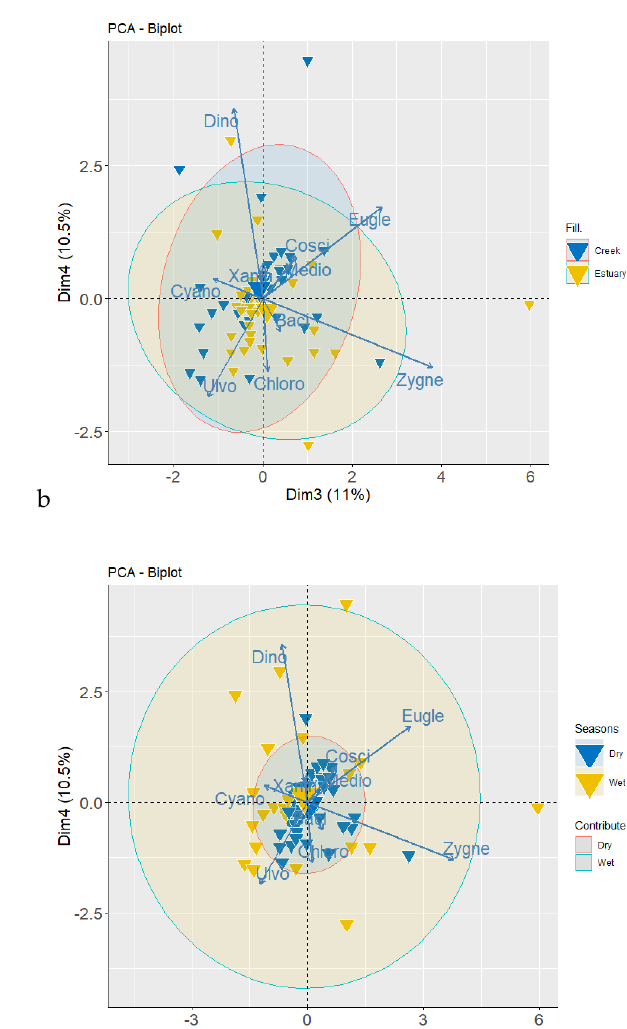
Figure 7. Biplot of the principal component analysis (PCA) of phytoplankton community distribution in the tidal mangrove creeks and the PRE (Baci: Bacillariophyceae, Cosci: Coscinodiscophyceae, Medio: Mediophyceae, Chloro: Chlorophyceae, Cyano: Cyanophyceae, Xanth: Xanthophyceae, Eugle: Euglenophyceae, Dino: Dinophyceae, Zygne: Zygnematophyceae and Ulvo: Ulvophyceae). ( a ) PCA biplot for the first and second axes between the creek and estuary, ( b ) PCA biplot for the third and fourth axes between the creek and estuary, ( c ) PCA biplot for the first and second axes between the dry and wet seasons, ( d ) PCA biplot for the third and fourth axes between the dry and wet seasons.